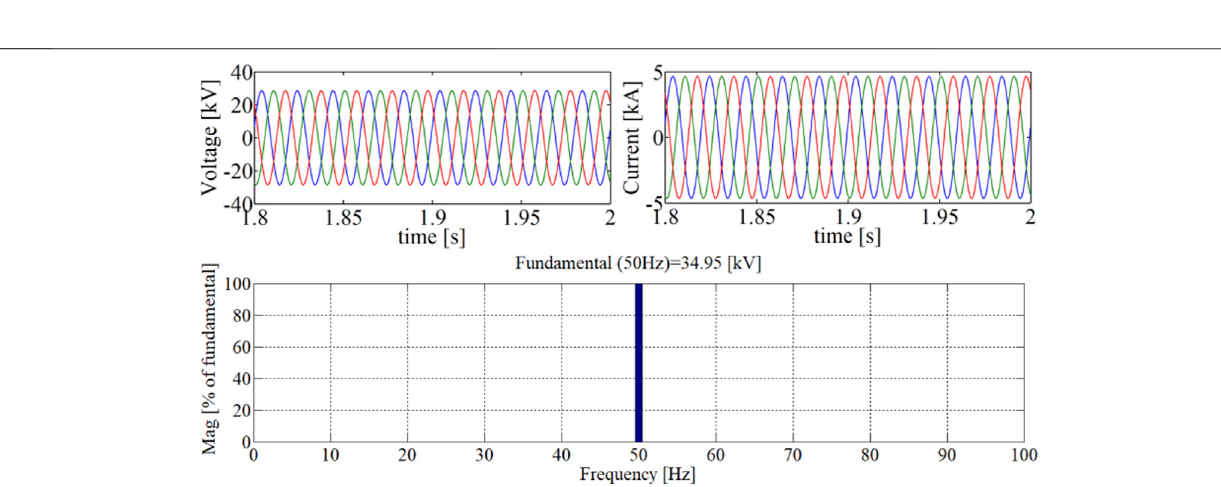
FIGURE 14 | Three-phase voltage and current at the 35-kV side of transformers and the FFT of voltage with 35-kV cable of 10 km.